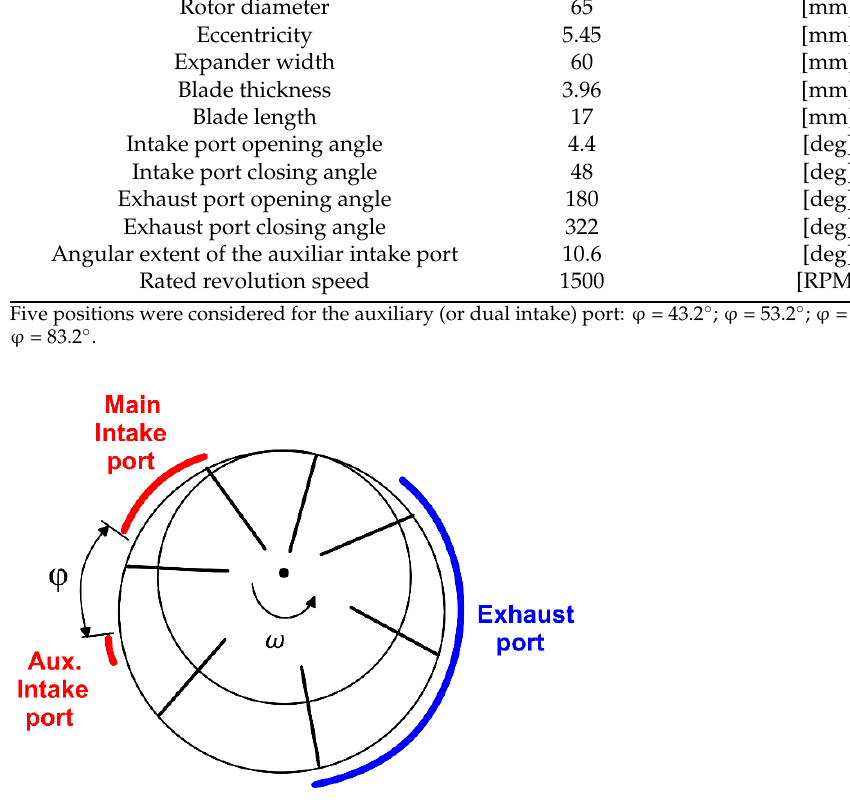
Figure 13. DIP SVRE expander.